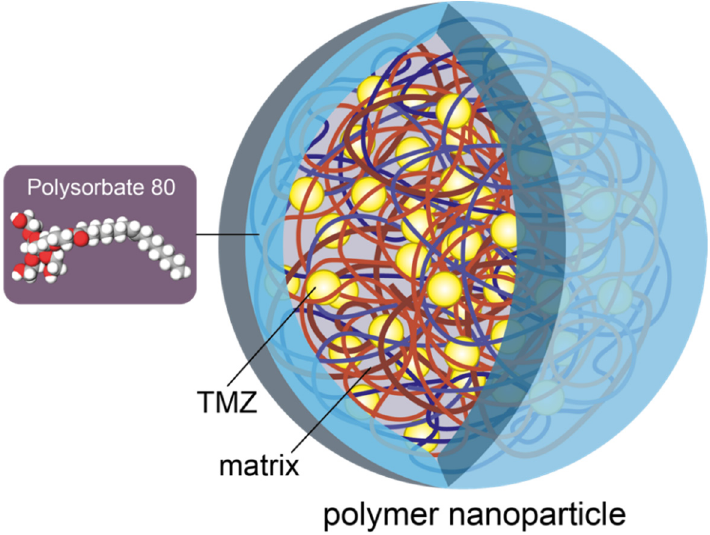
Figure 3. Polymer nanoparticle with polysorbate 80.